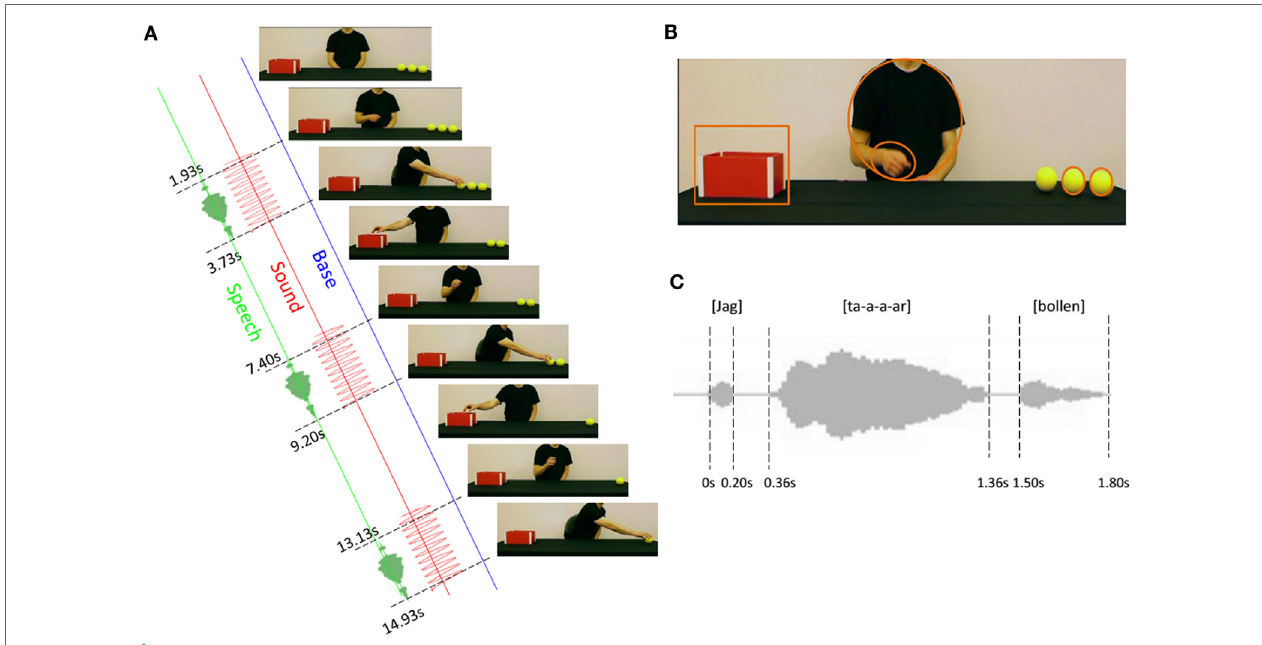
FigUre 1 | stimulus and procedure . Infants were presented with a video where an actor reached for three balls on a table and transported them into a box, in sequence. (a) A set of frames representing the reaching and transport of the balls with a schematic representation of the three experimental conditions. In the Base condition, no audio was associated to the video; in the Sound condition, a 680-Hz sine-wave sound was added in correspondence of the reaching movements and in the Speech condition a verbal signal accompanied the reaching movements (see Video S1 in Supplementary Material for a complete presentation of the stimuli used in the three conditions). (B) A frame of the video sequence with – superimposed – the five Areas of Interest adopted in the analysis of infants’ gaze. (c) Visualization of the verbal signal associated to the reaching action in the Speech condition. The “tar” sound (corresponding to “take”) was prosodically marked by extending the “a”